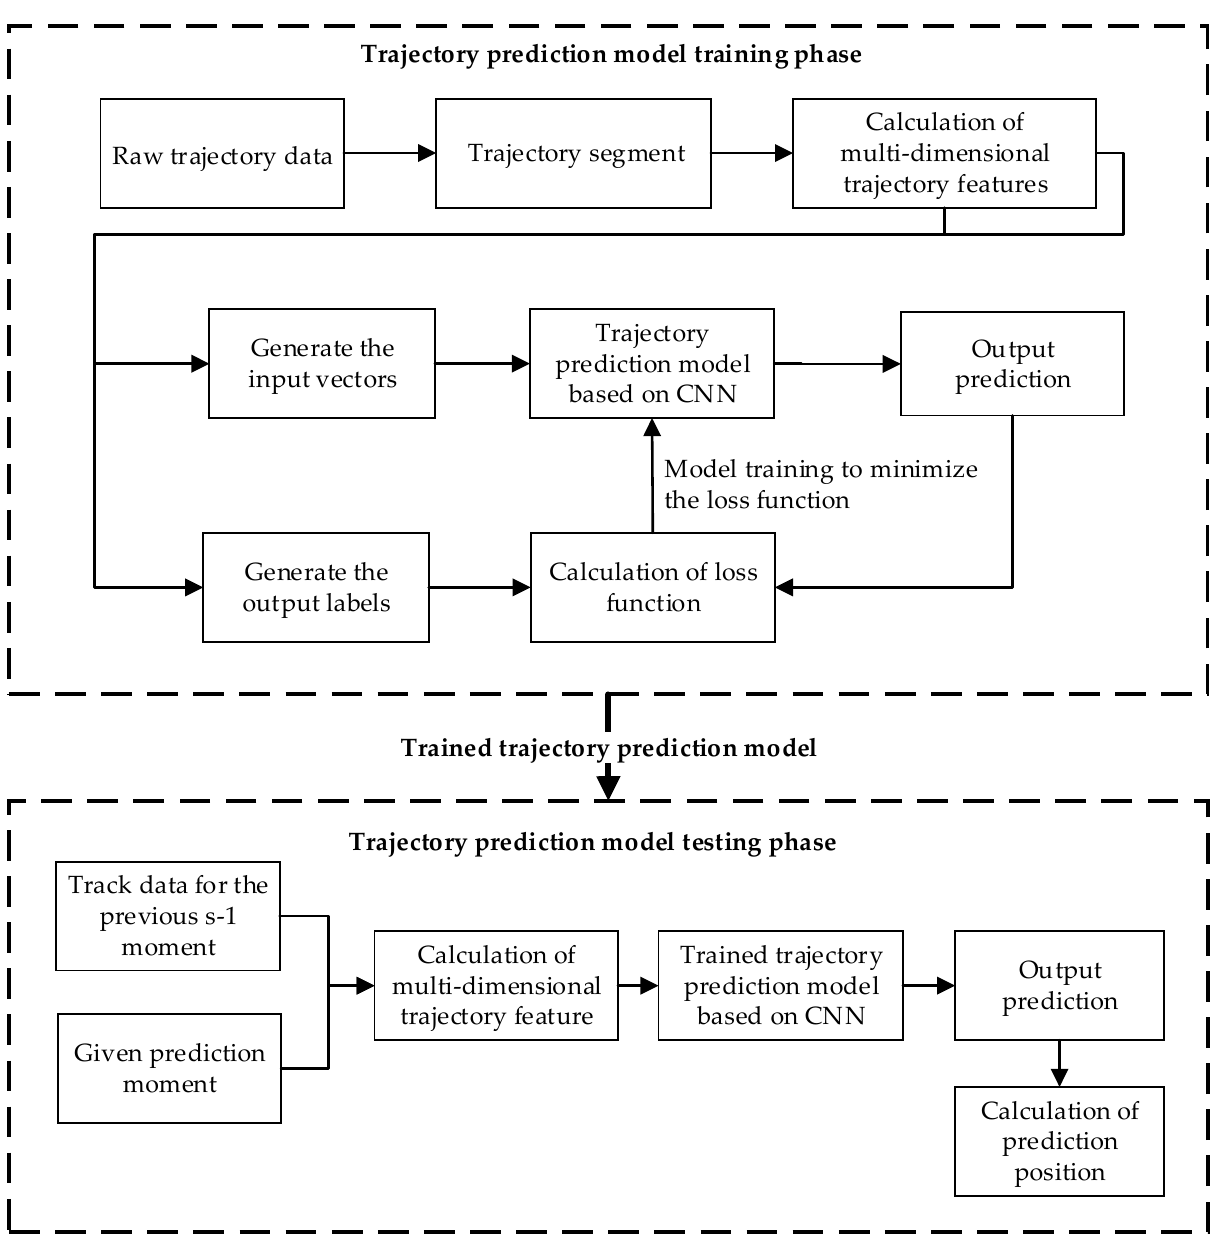
Figure 4. Diagram of the Training and Testing Process of the Trajectory Prediction Model.